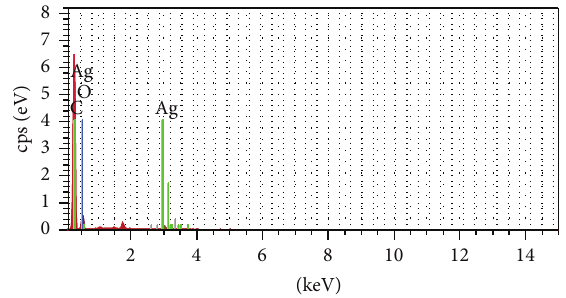
Figure 6: EDX component analysis of nanosilver prepared using pure water.